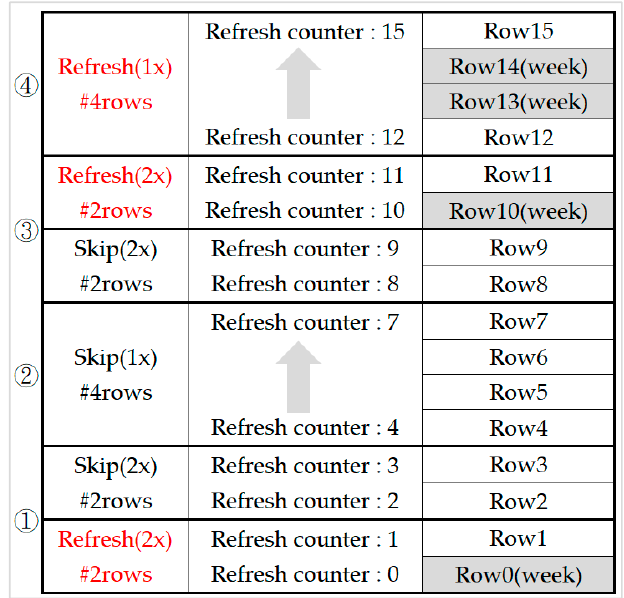
Figure 7. Retention-aware auto-refresh.